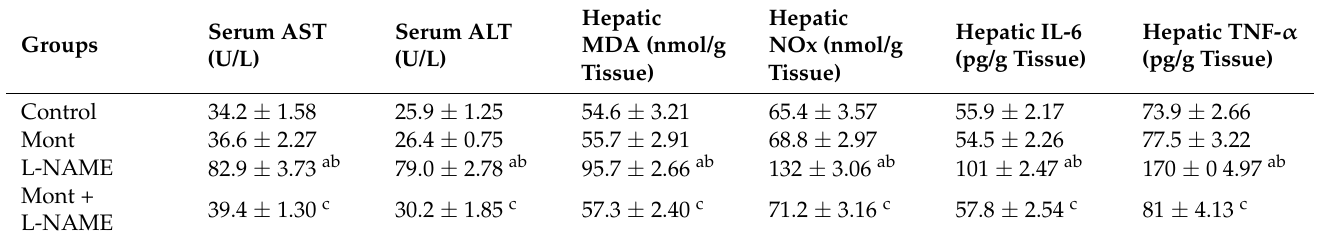
Table 2. Effect of montelukast on hepatic parameters in a pre-eclampsia model in